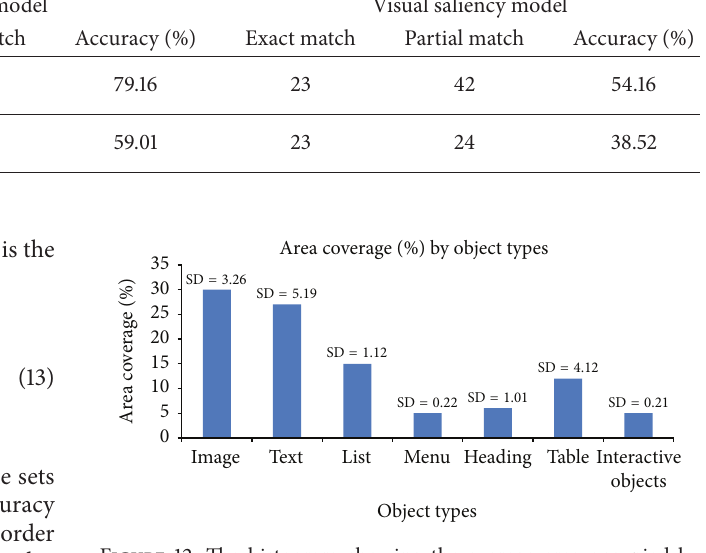
Figure 12: The histogram showing the average area occupied by the different objects in the web pages used in the second validation